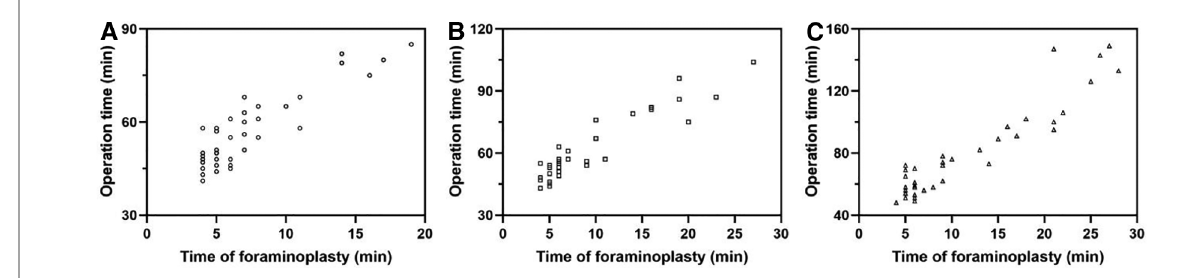
FIGURE 4 Time of foraminoplasty and operation time among three surgeons. ( A ): Dr. Fan. ( B ): Dr. Pu. ( C ): Dr. Wang.